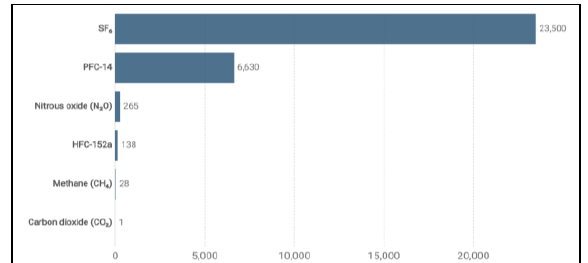
Figure 2. Global warming potential